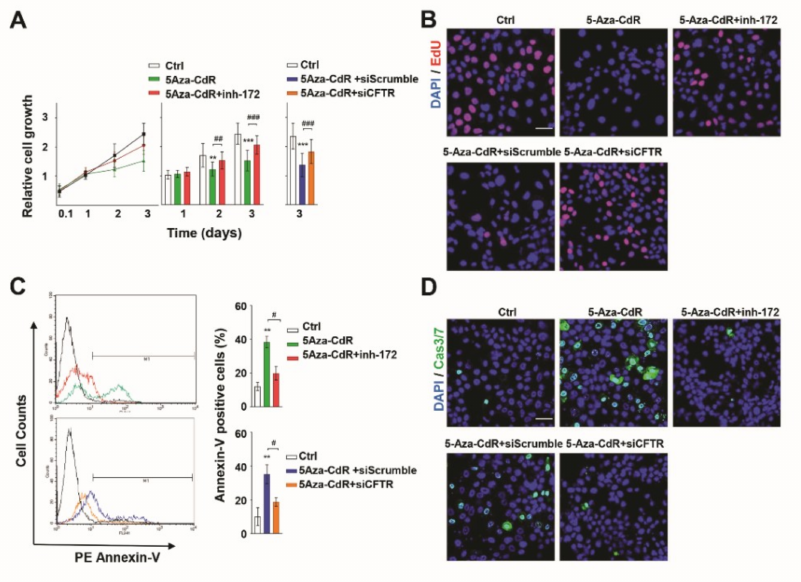
Figure 6. Epigenetic induction of CFTR; proliferation and apoptosis in A253 cells ( A ) Cell growth was measured for 2.4, 24, 48, and 72 h in A253 cells with DMSO (vehicle), 5-Aza-CdR only, or CFTR inh -172 + 5-Aza-CdR by CCK-8 assay (left and middle graphs). Cell growth was also compared among control, scrambled siRNA + 5-Aza-CdR, and CFTR siRNA + 5-Aza-CdR (right graph) ( n = 15). CFTR silencing with CFTR siRNA or CFTR inh -172 prevented 5-Aza-CdR e ff ects. Cell growth was inversely proportional to CFTR functional expression. ( B ) Proliferating cells (red) were detected with 5-ethynyl-2 (cid:48) -deoxyuridine (EdU) and compared with total cells by nuclear staining (Hoechst, blue). Scale bar = 50 µ m ( n = 3). Proliferation suppressed by 5-Aza-CdR treatment, increased in CFTR-silenced (CFTR inh -172 or CFTR siRNA) + 5-Aza-CdR treatment. ( C ) Apoptotic cells analyzed by PE / annexin-V assay using flow cytometry after 3 days’ treatment (left side) showing 5-Aza-CdR-induced apoptosis and CFTR induced anti-apoptosis. Quantification of annexin-V assay in graphs (right side) of three experiments ( n = 3). ( D ) Caspase 3 / 7 activity (Cas3 / 7, green) was detected by immunostaining assay ( n = 3). Active caspase 3 / 7 activation observed in 5-Aza-CdR-treated cells with or without scrambled siRNA but prevented by CFTR inhibition. Nuclei stained with Hoechst (blue). Data are mean ± SD. One and two-way ANOVA with Bonferroni’s multiple comparison tests for significance (* or # , p < 0.05; ** or ## , p < 0.01; *** or ### , p < 0.001). * denotes statistical significance compared with control, # denotes significance compared with 5-Aza-CdR-treated